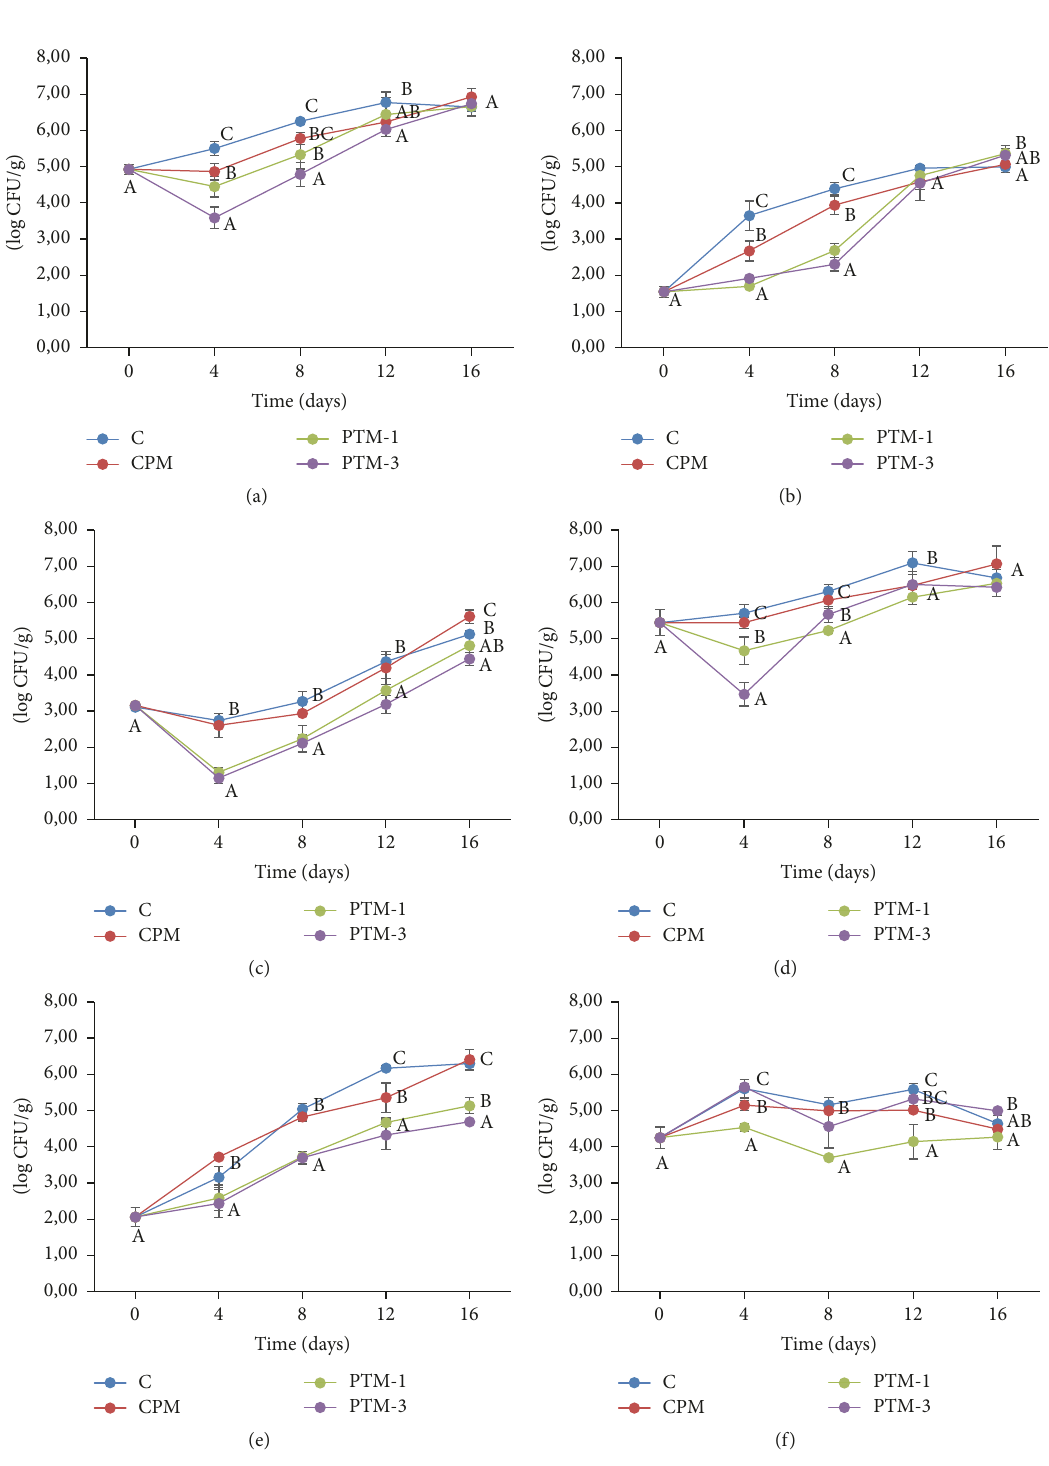
Figure 4: Evolution of the natural microbiota of WPI-Thy coated hake fillets stored under MAP conditions. C: control; CPM: control-WPI; PTM-1: WPI + Thy 1%; PTM-3: WPI-Thy 3%. (a) Total viable counts; (b) lactic acid bacteria; (c) Enterobacteriaceae ; (d) psychrotrophic bacteria; (e) H 2 S- producing bacteria; (f)